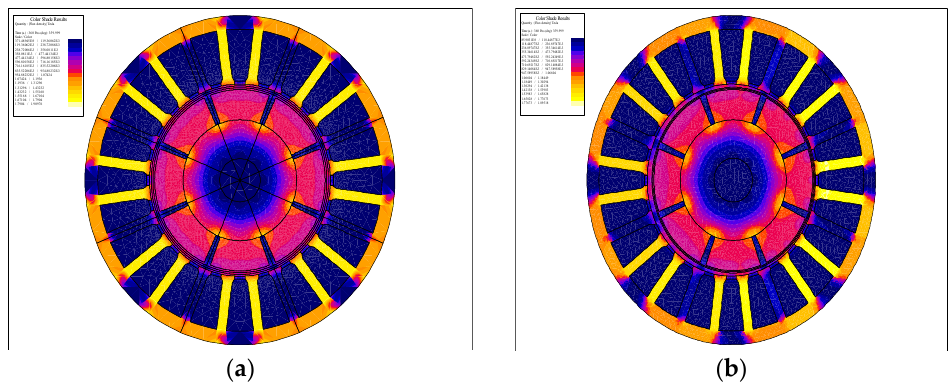
Figure 7. Distribution of magnetic flux density: ( a ) healthy; ( b ) eccentric distance is 0.2 mm.